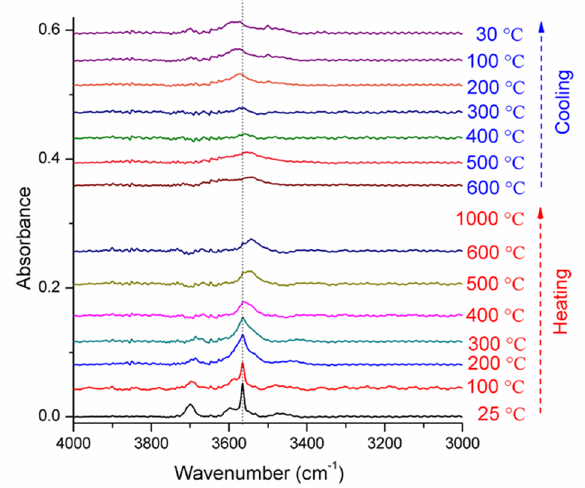
Figure 9. IR spectra change in shape and position of the OH absorptions with temperature (infrared light perpendicular to (010), electric vector E of the light wave is parallel to [001]).